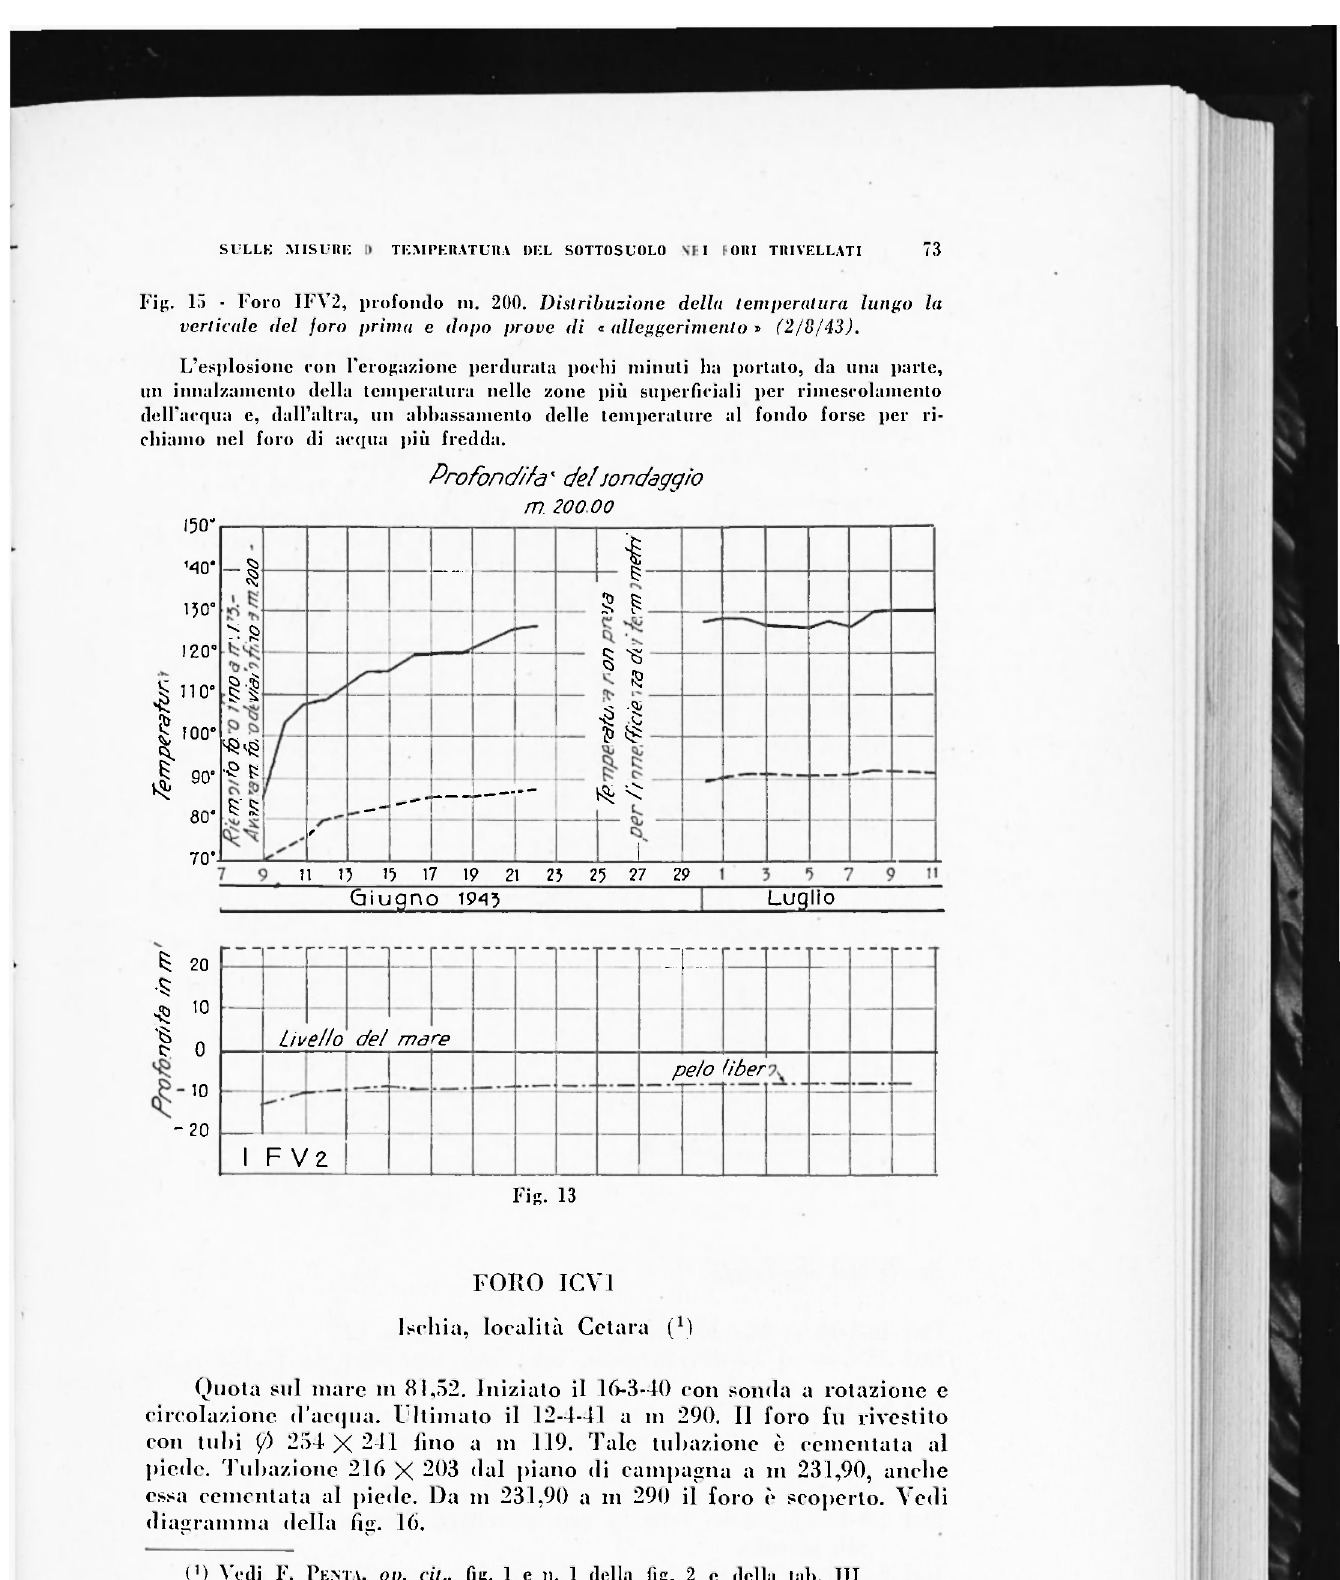
F O RO I C V1 Ischia, località Cetara ( 1